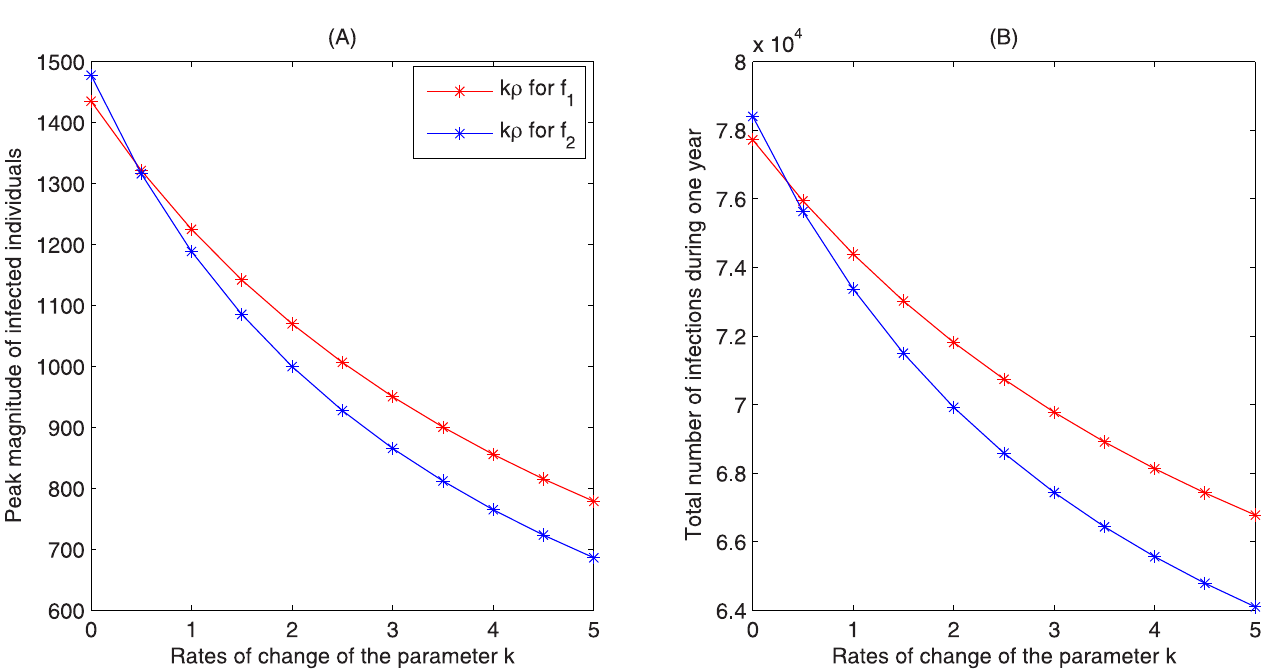
Fig 8. Plots of the peak magnitude and total infections by varying k (the rates of change of ρ ). The red and blue curves with asterisk markers are the results by using function f 1 and f 2 , respectively. Each column of markers denotes that k increases 50% per time. All the other parameters are fixed as shown in Table 1.